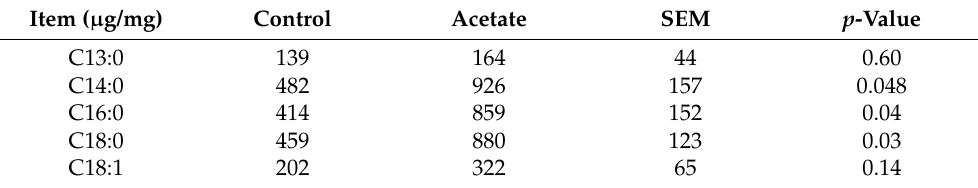
Table 2. The long-chain fatty acid composition of bovine mammary epithelial cells.